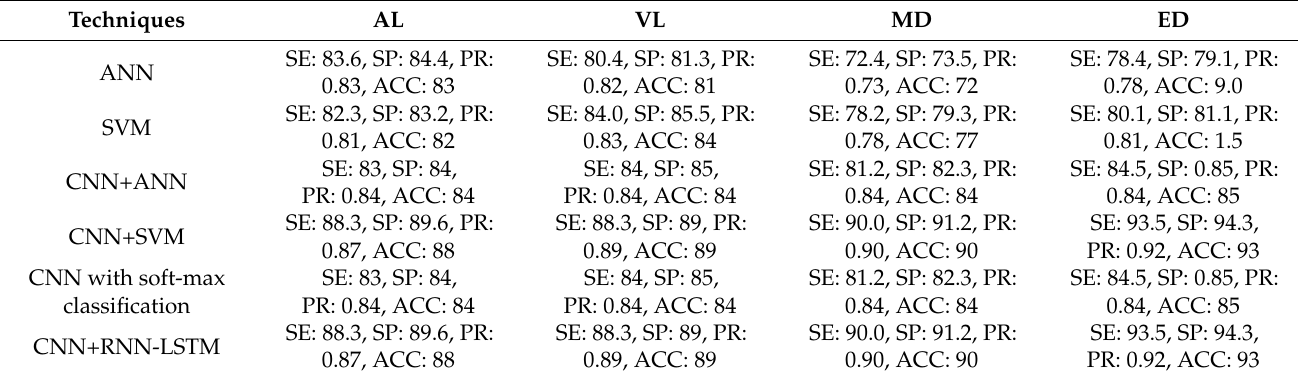
Table 8. Comparisons results based on 4-class based DFD systems by using 20 different subjects; recorded time is 40